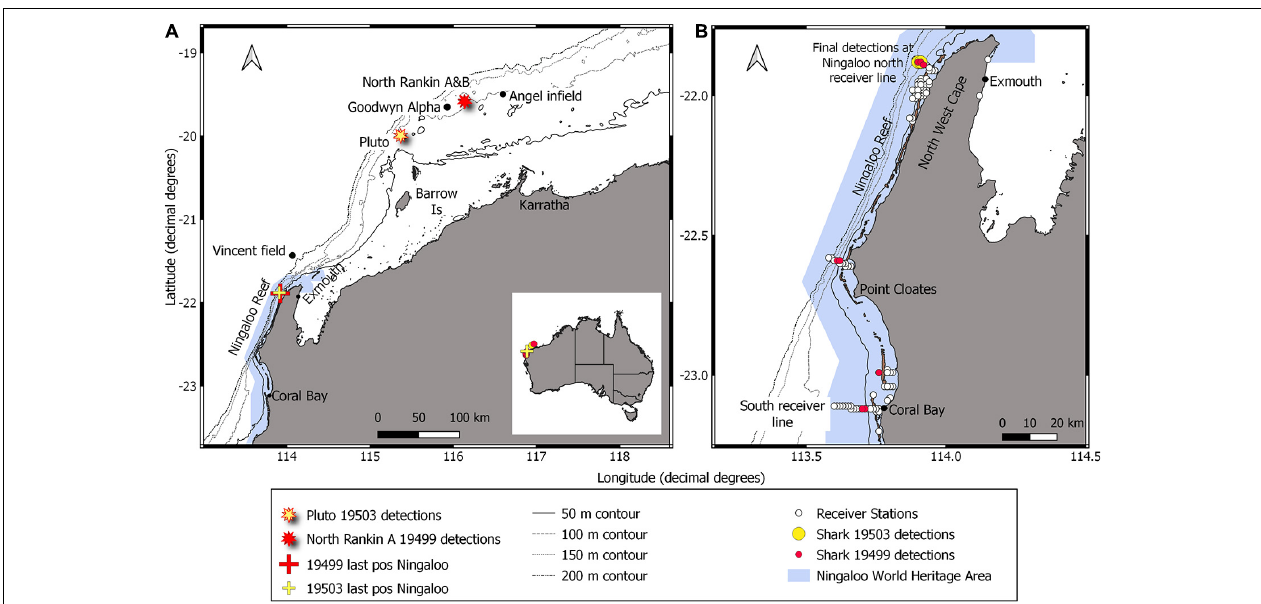
FIGURE 1 | (A) Location of Ningaloo Reef and positions of platforms Pluto, North Rankin complex (A&B) and Goodwyn Alpha, and the approximate pipelines survey locations of the Angel infield and Vincent fields on the North West Shelf. Also shown are last known positions of two whale sharks tagged with acoustic transmitters at the World Heritage Ningaloo Reef before being detected again at North Rankin A and Pluto platforms. (B) Acoustic receiver stations of the IMOS/CSIRO Ningaloo Reef Ecosystem Tracking Array and detection locations of the two tagged whale sharks later detected at Pluto and North Rankin A platforms. Shark 19503 was detected 26 times over 2 days in the area where it was tagged on the receiver north line and was not detected again until Pluto platform. Shark 19499 was detected 182 times within the Ningaloo region over the next 12 months at 10 receiver stations between the north and south extent of the deployed receivers. Note that all shark 19503 detections that occurred within a small area cannot be shown due to map scale.